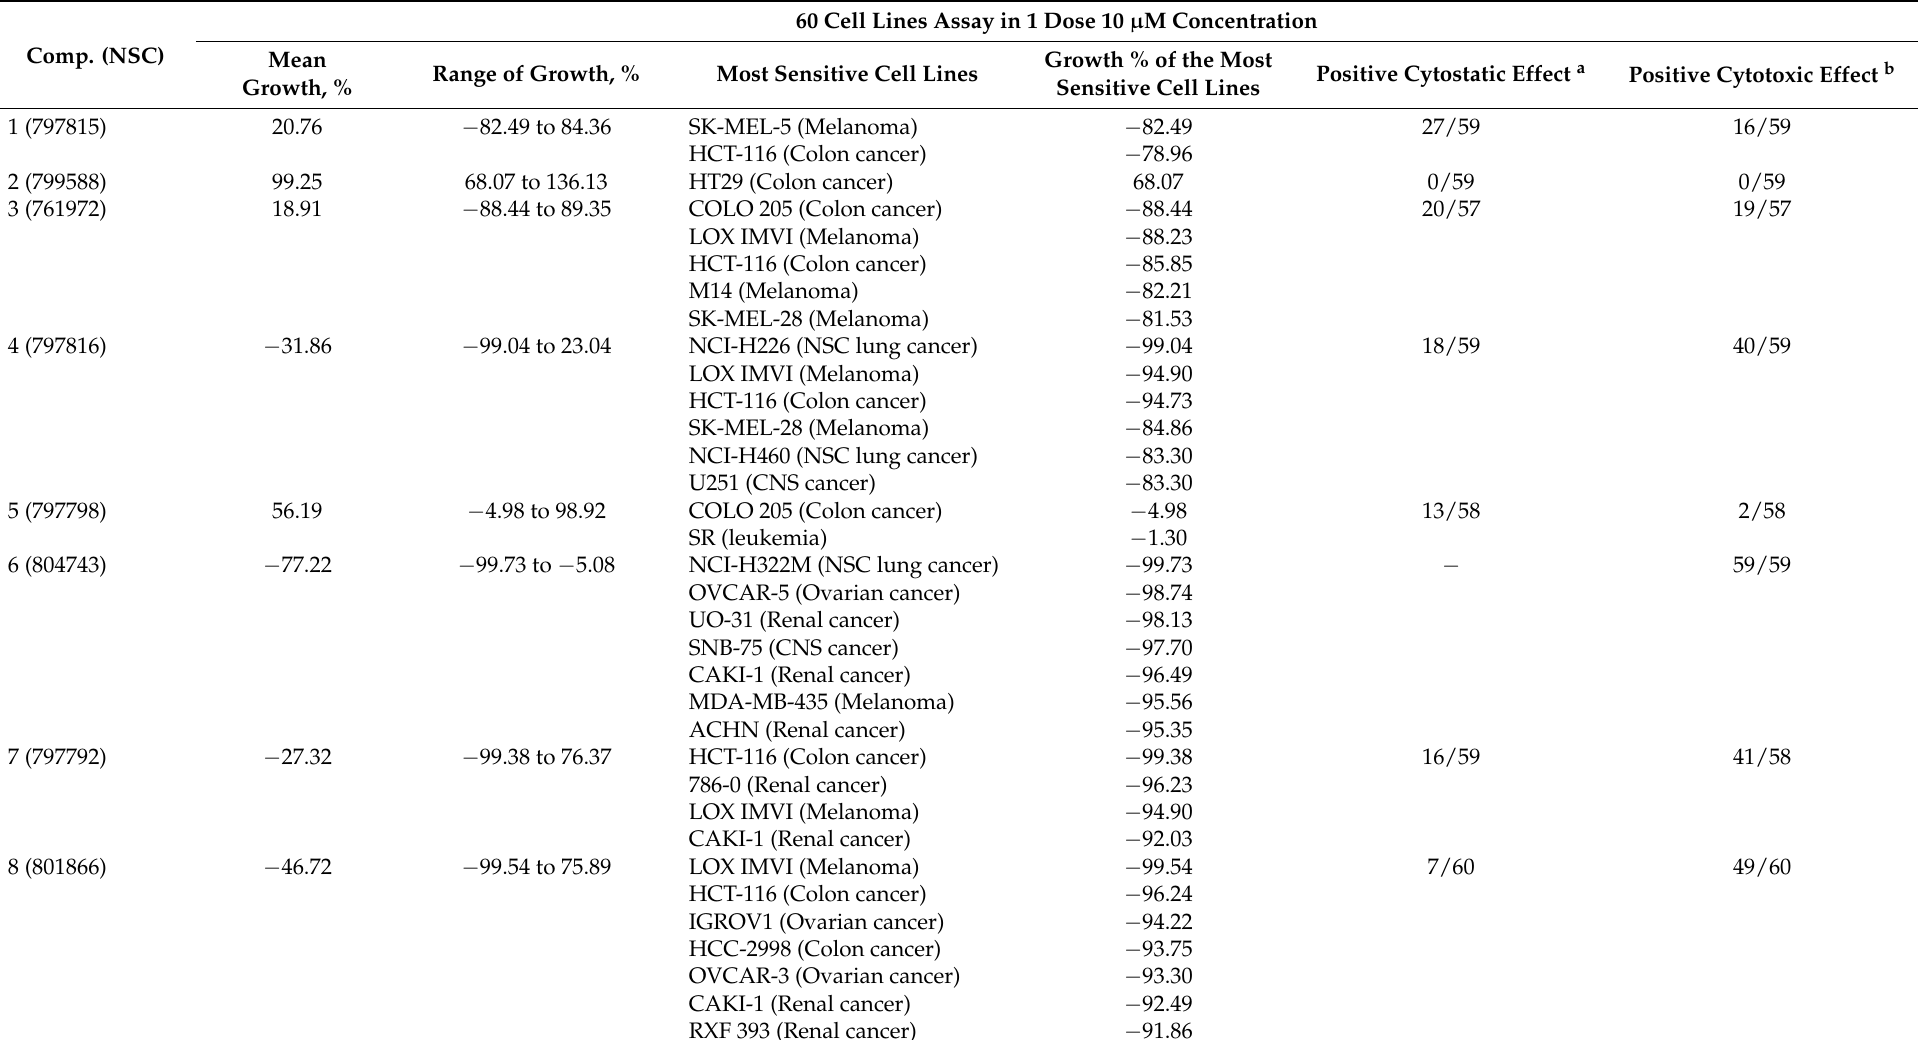
Table 3. Anticancer screening data in concentration 10 µ